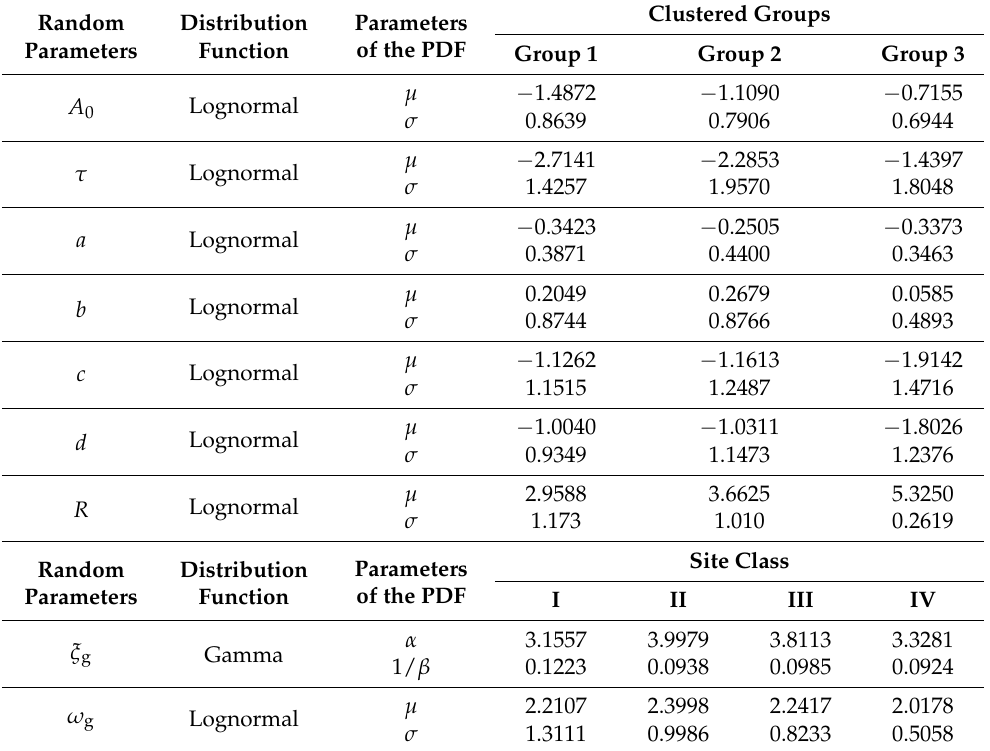
Table 2. Parameters of PDFs of random parameters of the stochastic semi-physical model of seismic ground